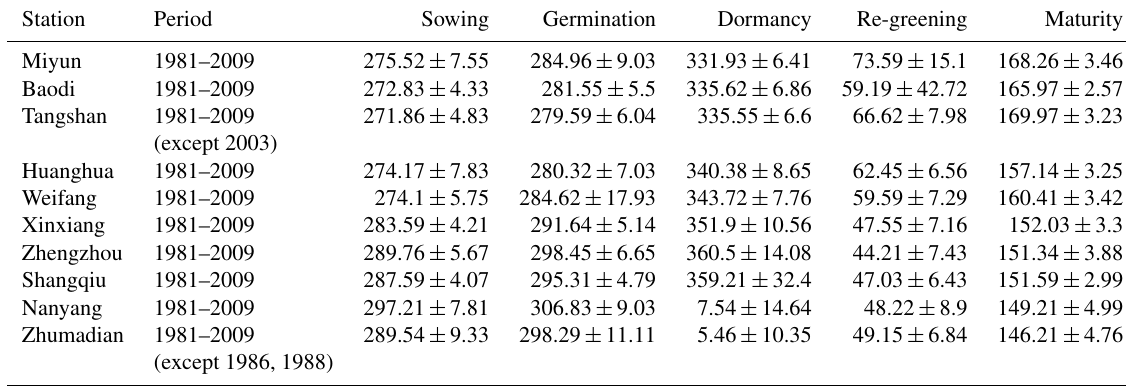
Table 3. General information on the phenology of winter wheat in the selected stations (unit: DOY). Station